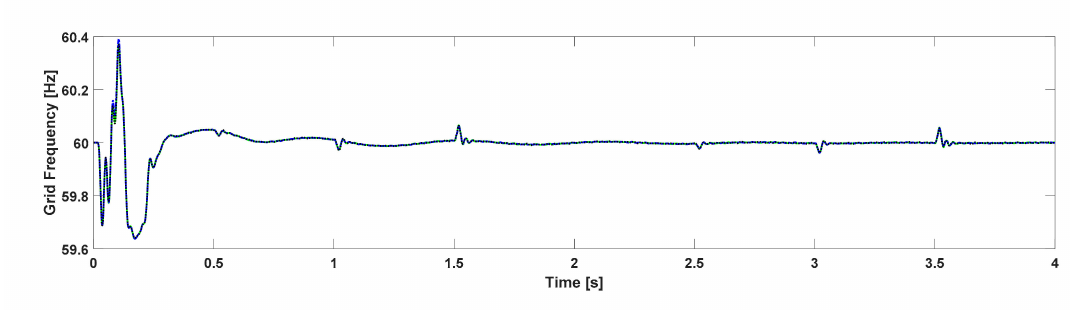
Figure 16. Measured frequency at 11-kV bus during fault-free operation.